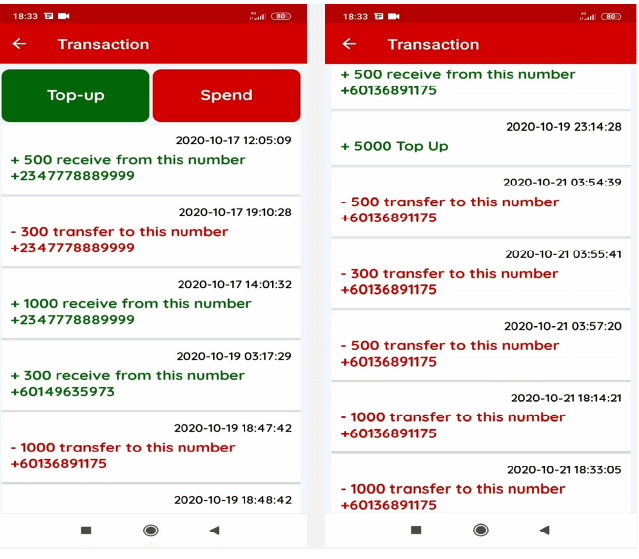
Figure 16. View transaction activity of Zamwallet.